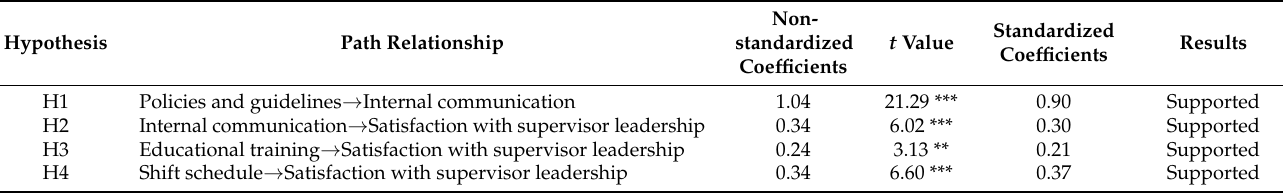
Table 5. Relationship analysis of the finalized structural equation